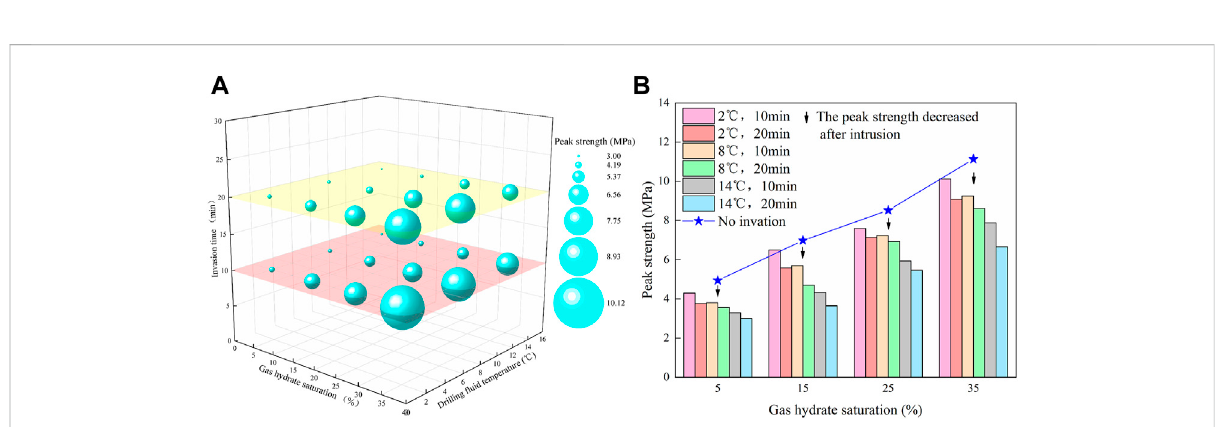
FIGURE 11 Thepeakstrengthsofhydrate-bearingsedimentsafterdrilling fl uidinvasionvarywithhydratesaturation,drilling fl uidtemperature,andinvasion time. (A) The peak strengths of the hydrate-bearing sediments are expressed in terms of bubble size. (B) Peak strength variations before and after drilling fl uid